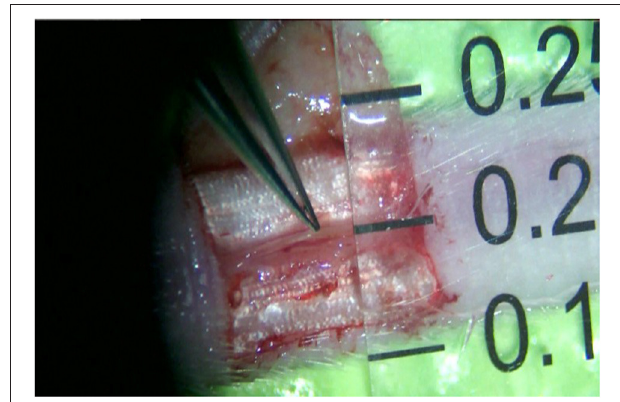
FIGURE 4 | The successfully anastomosed mouse middle caudal artery. The red arrow shows the anastomosis site.